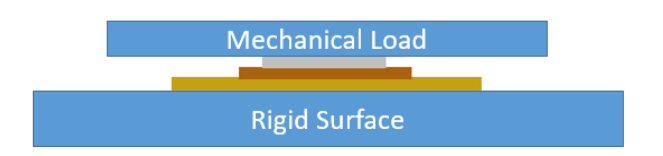
Figure 10. Experimental arrangement for mechanical